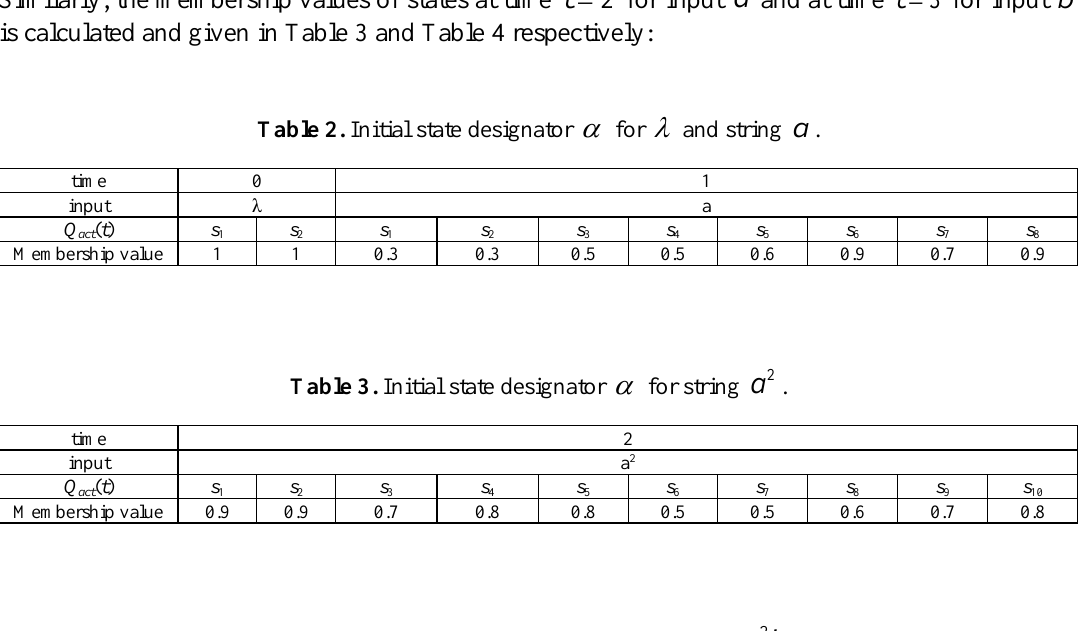
Table 4. Initial state designator  for